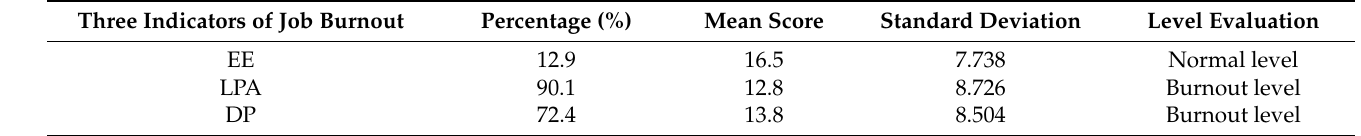
Table 2. Evaluation of level of job burnout in the three indicators (N =